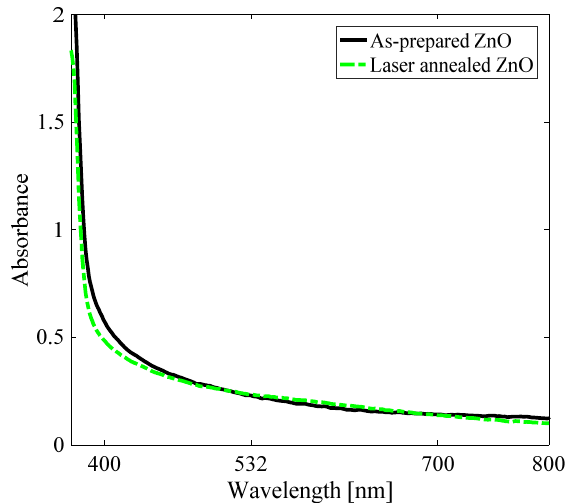
Figure 5. Representative UV–vis absorbance spectra of the ZnO samples.